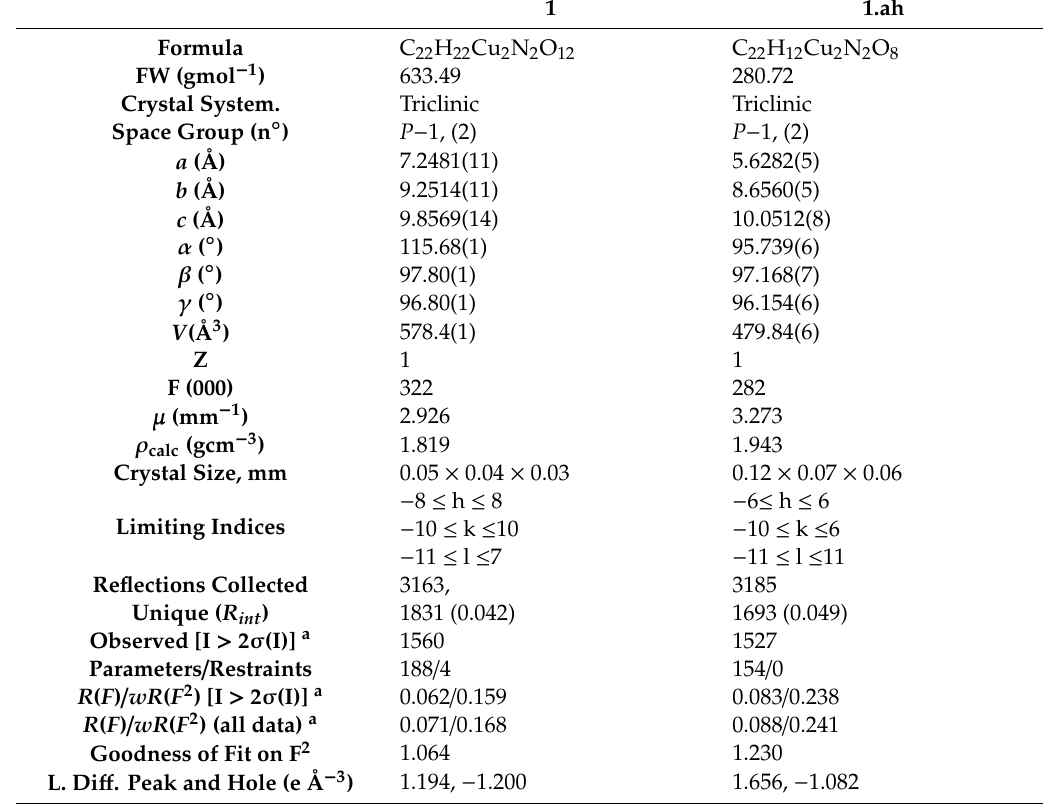
Table 6. Parameters of the crystal data, structural resolution and refinement procedure for 1 and